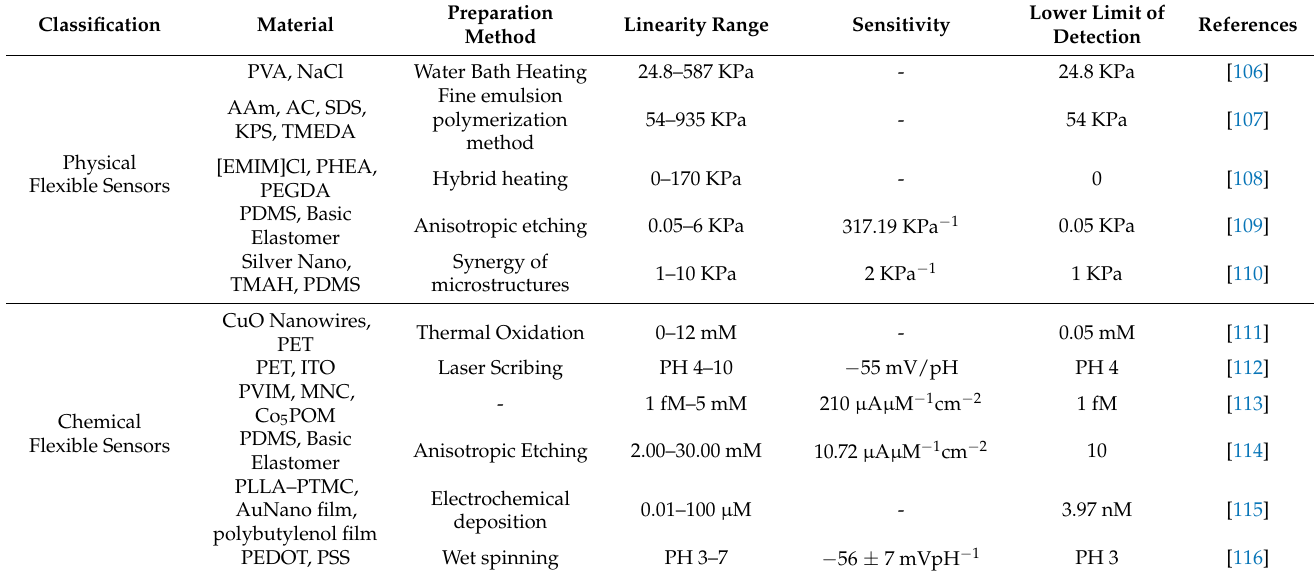
Table 2. Comparative study of flexible sensors with different detection